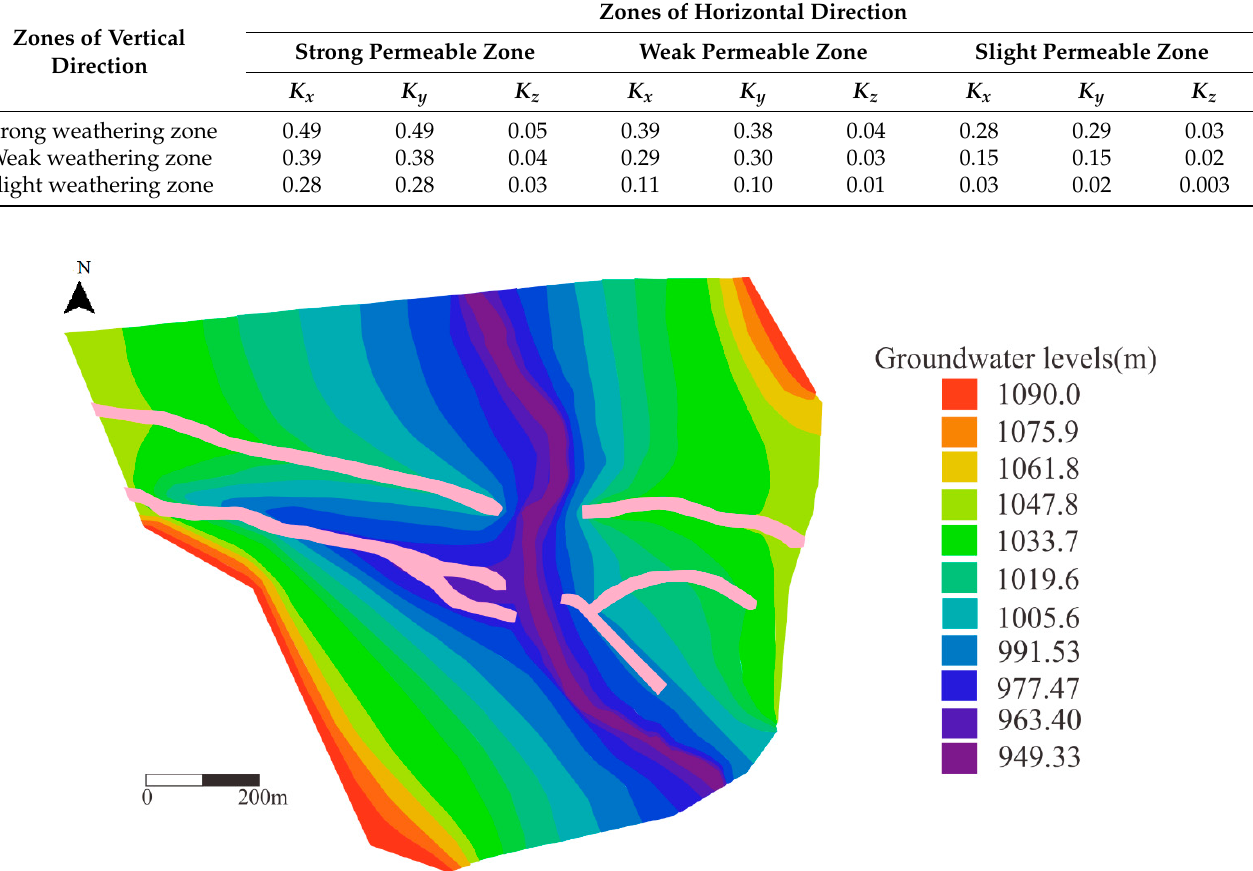
Table 7. Permeability coefficients of fracture-karst media by inversion method (m/d).